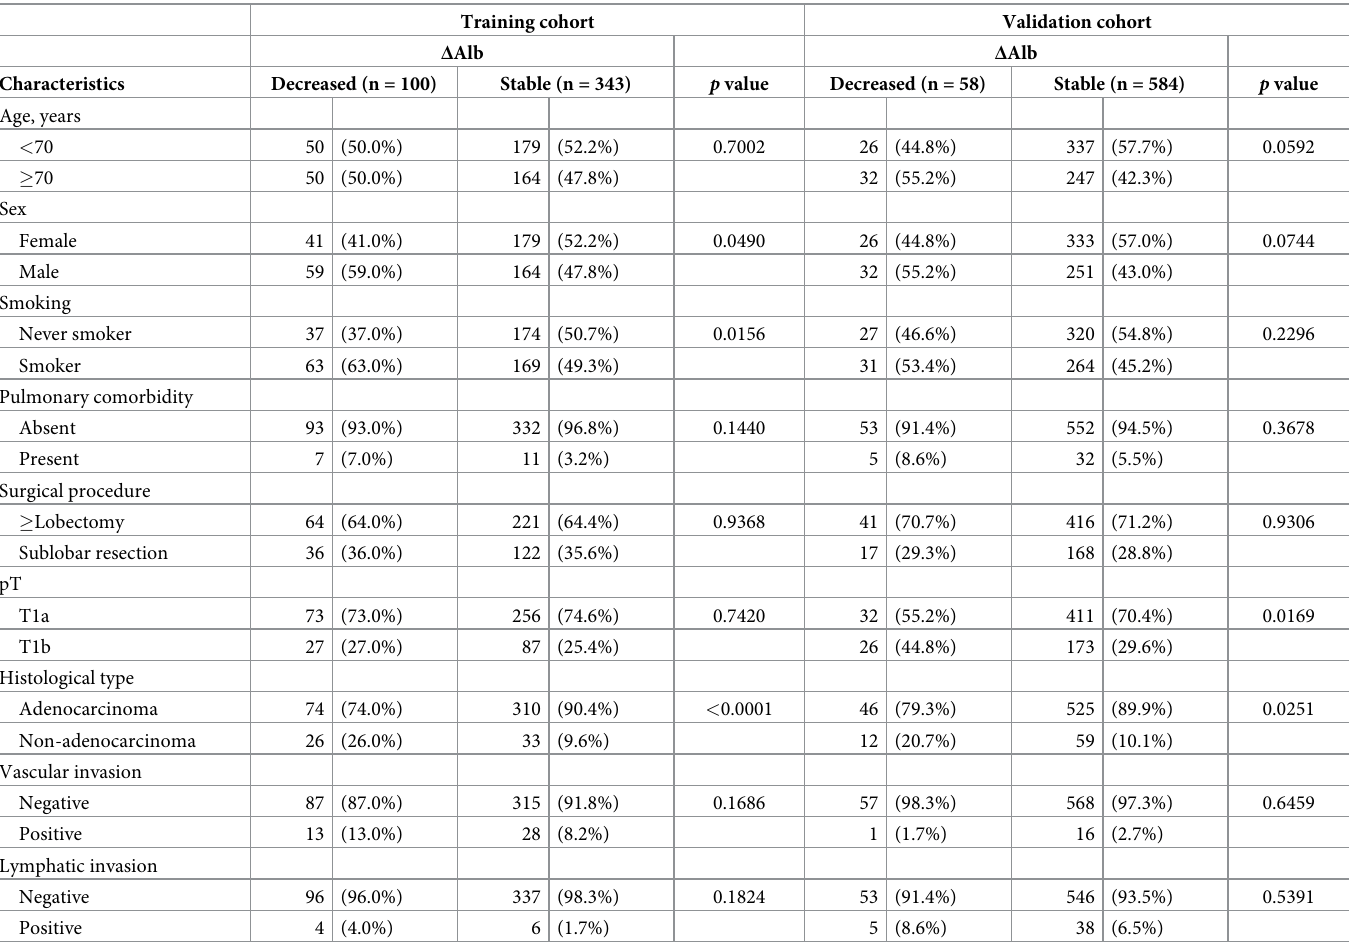
Table 1. Associations of clinicopathological characteristics with Δ